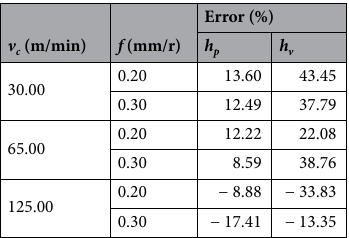
Table 12. Model error percentage for the average h p and h v values compared with experimental